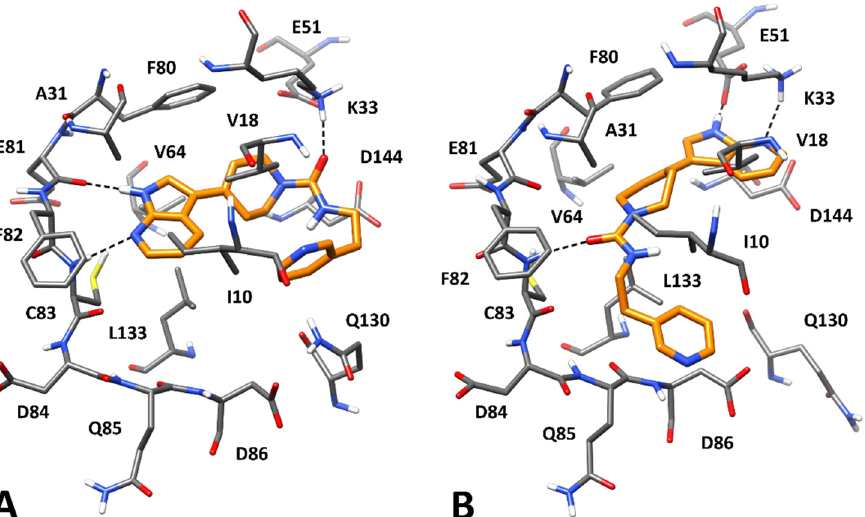
Figure 3. Minimized average structures of CPD1 (orange) in complex with Cdk5. The two different binding modes represented by ( A ) cluster 1 and ( B ) cluster 2 are shown. The protein residues surrounding the ligand, constituting the binding site, are shown as grey sticks, whereas hydrogen bonds are shown as black dashed lines.